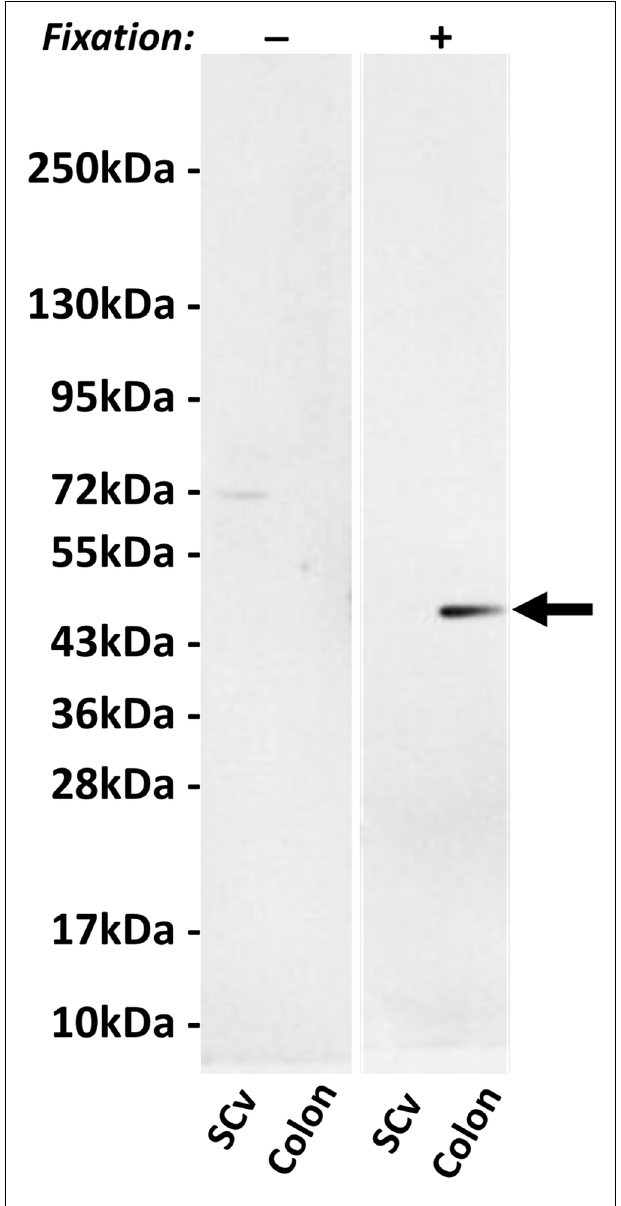
FIGURE 2 | Western blot using hpChAT antiserum on tissue extracts of human ventral spinal cord (SCv) at the cervical level and ascending colon after SDS-PAGE followed by blotting on nitrocellulose membranes with (+) or without ( − ) paraformaldehyde (PFA) fixation. After fixation, positive hpChAT-immunoreactive (ir) labeling is seen only in a single band of approximately 47 kDa (black arrow) of colon. Molecular weight markers are shown in kDa at the left